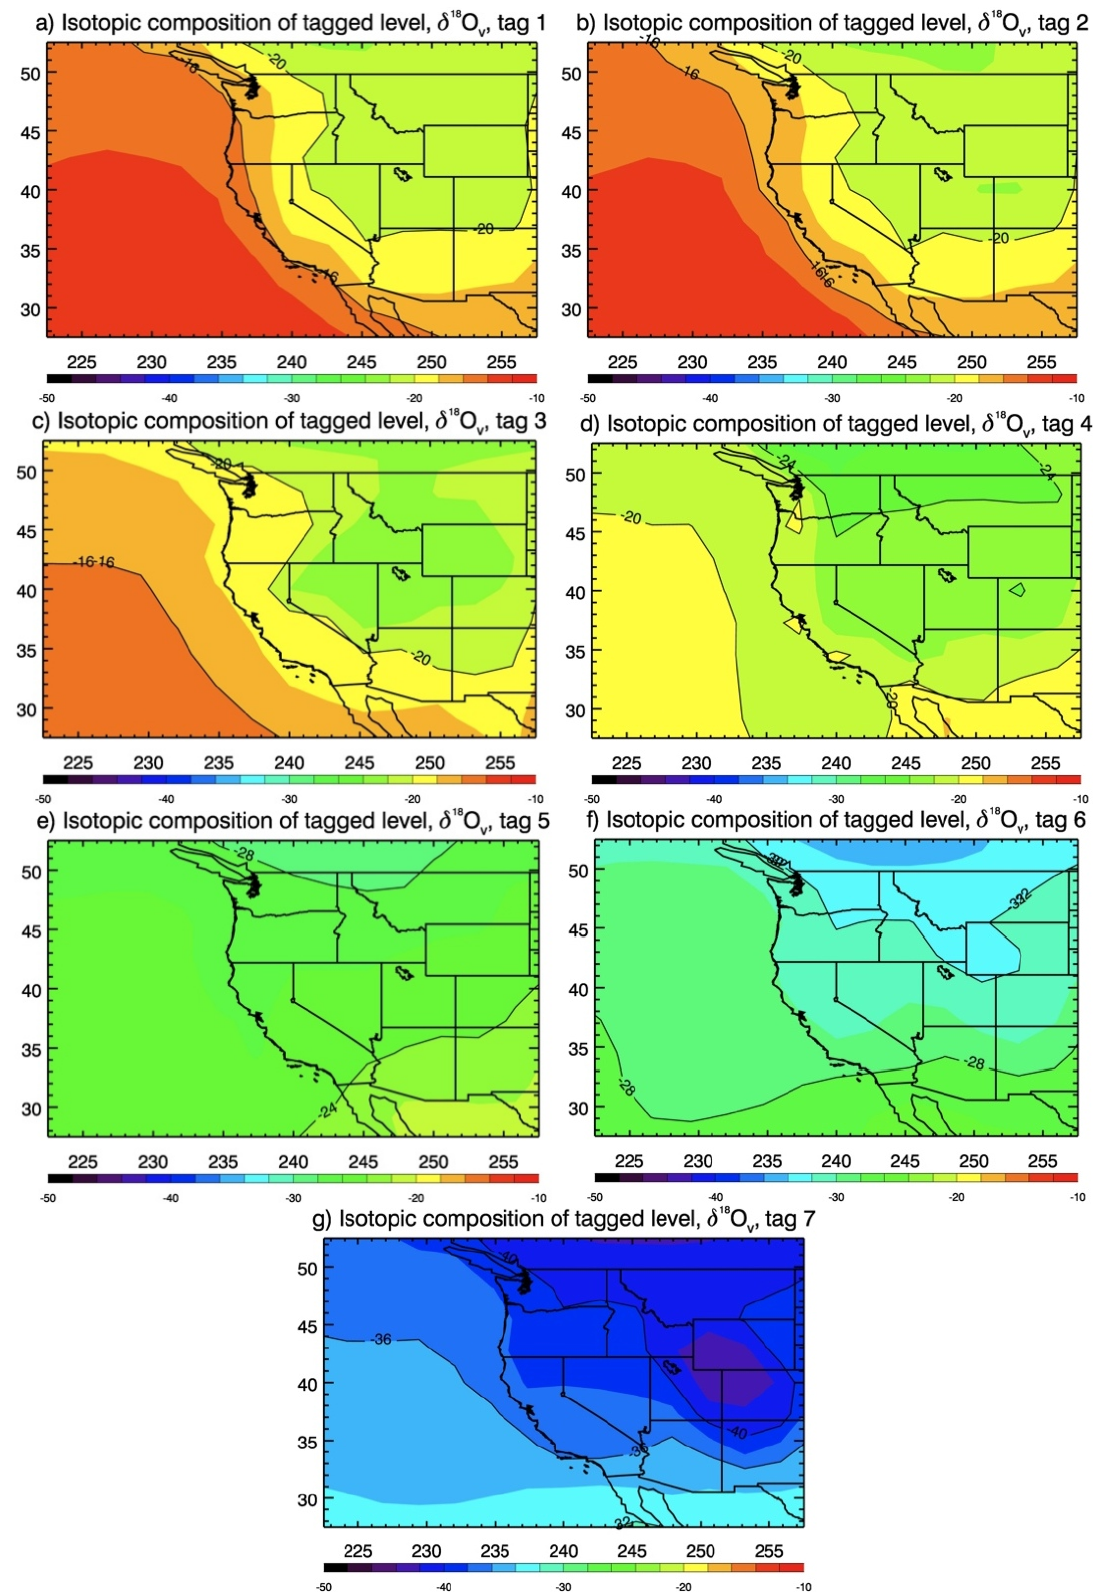
Figure 7. ( a – g ) The isotopic composition of vapor ( δ 18 O vertical tags. Mean values are calculated by weighting vertical δ 18 O simulation by the vertical distribution of the given tag. The bottommost tag is shown in panel a (tag 1), and higher level tags are shown in panels ( b )–( g ). Contour intervals are